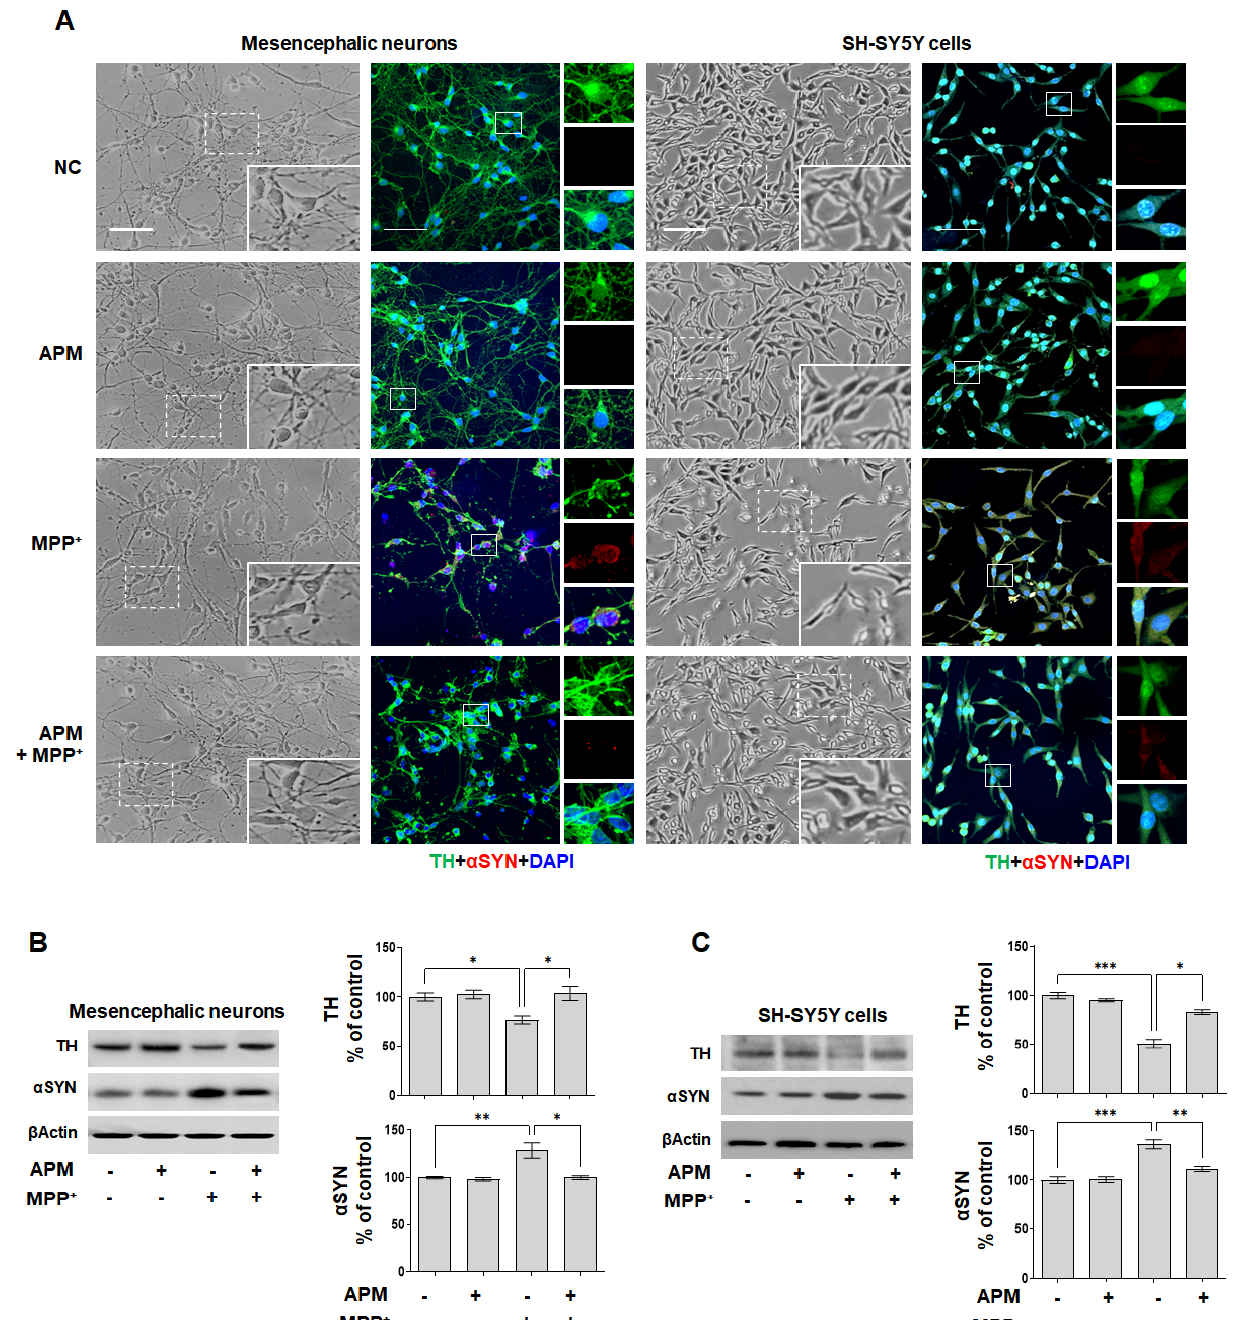
Figure 1. Effects of APM on MPP + -induced TH and α SYN expression in dopaminergic neuronal cells. SH-SY5Y cells and rat embryo primary mesencephalic neurons were incubated in the presence or absence of APM for 1 h and then treated with MPP + for 24 h. ( A ) The morphological changes, TH and α SYN expression in dopaminergic neurons after exposure to MPP + in the presence or absence of APM. Immunofluorescence staining for TH (green) and α SYN (red) localization. Cells were counterstained with DAPI (blue). Scale bars: 50 μ m. APM strongly reduced expression of TH reduction and accumulation of α SYN in rat embryo primary mesencephalic neurons ( B ), and SH-SY5Y cells ( C ). β Actin was used to confirm equal sample loading. Immunoblotting was quantified by densitometric analysis. The data are representative of three independent experiments and quantified as mean values ± SEM. Tukey’s multiple comparison test, * p < 0.05, ** p < 0.01, *** p < 0.001 compared to normal control.